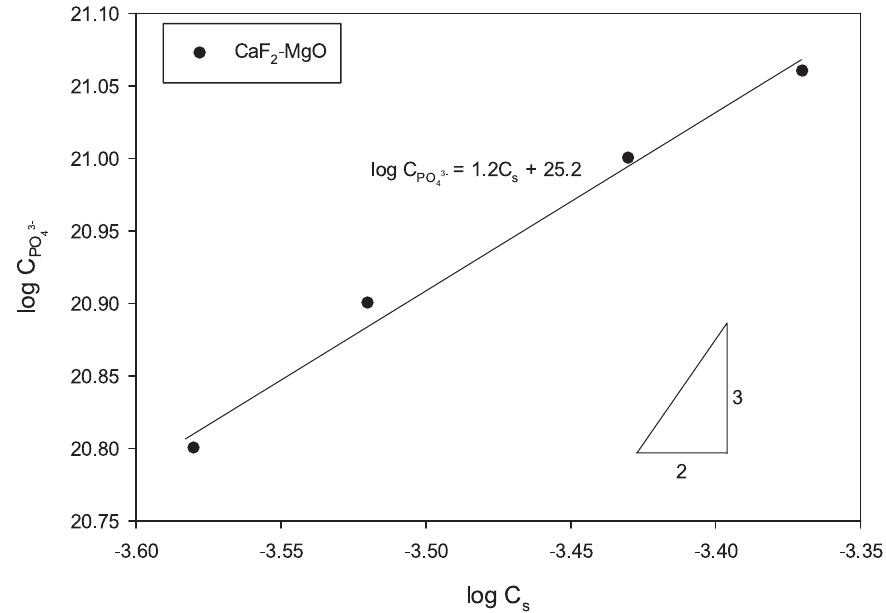
Fig. 1: Correlation between phosphate and sulphide capacities in CaF 2 -MgO binary slags at 1450 °C. The phosphate capacity data was taken from reference [25] and the sulphide capacity data from reference